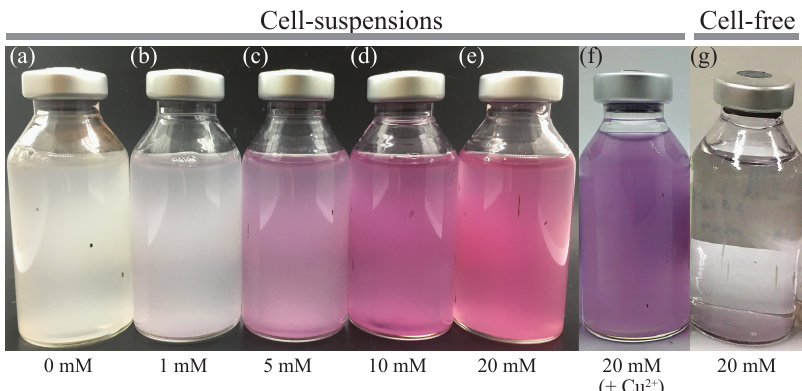
Figure 4. Color change of Ac. aromatica cell-suspensions after Au(III) reduction (at 160 h after exposure to 10 mg / L Au(III)). Formate was added as e-donor at; ( a ) 0 mM, ( b ) 1 mM, ( c ) 5 mM, ( d ) 10 mM, or ( e ) 20 mM. ( f ) As a possible enzymatic inhibitor, 5 mM Cu 2 + was simultaneously added together with 20 mM formate. ( g ) Cell-free controls were also tested at 20 mM formate.